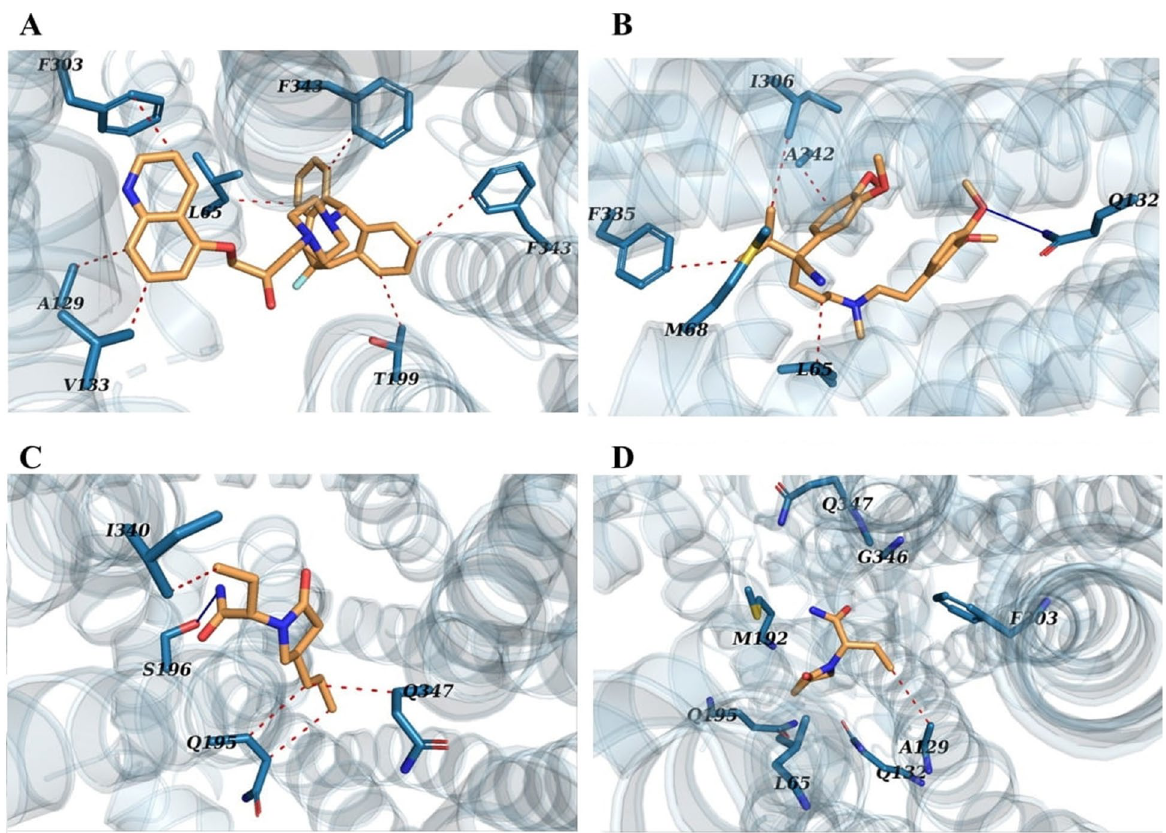
Figure 1. Human P-gp complex with ( A ) zosuquidar, ( B ) verapamil, ( C ) brivaracetam, and ( D ) levetiracetam, after molecular dynamics simulations. hP-gp is represented as light blue cartoon, and ligands as wheat sticks. The key residues (blue sticks) are labeled. Hydrogen bonds are shown as blue line, and hydrophobic interactions in red dots.